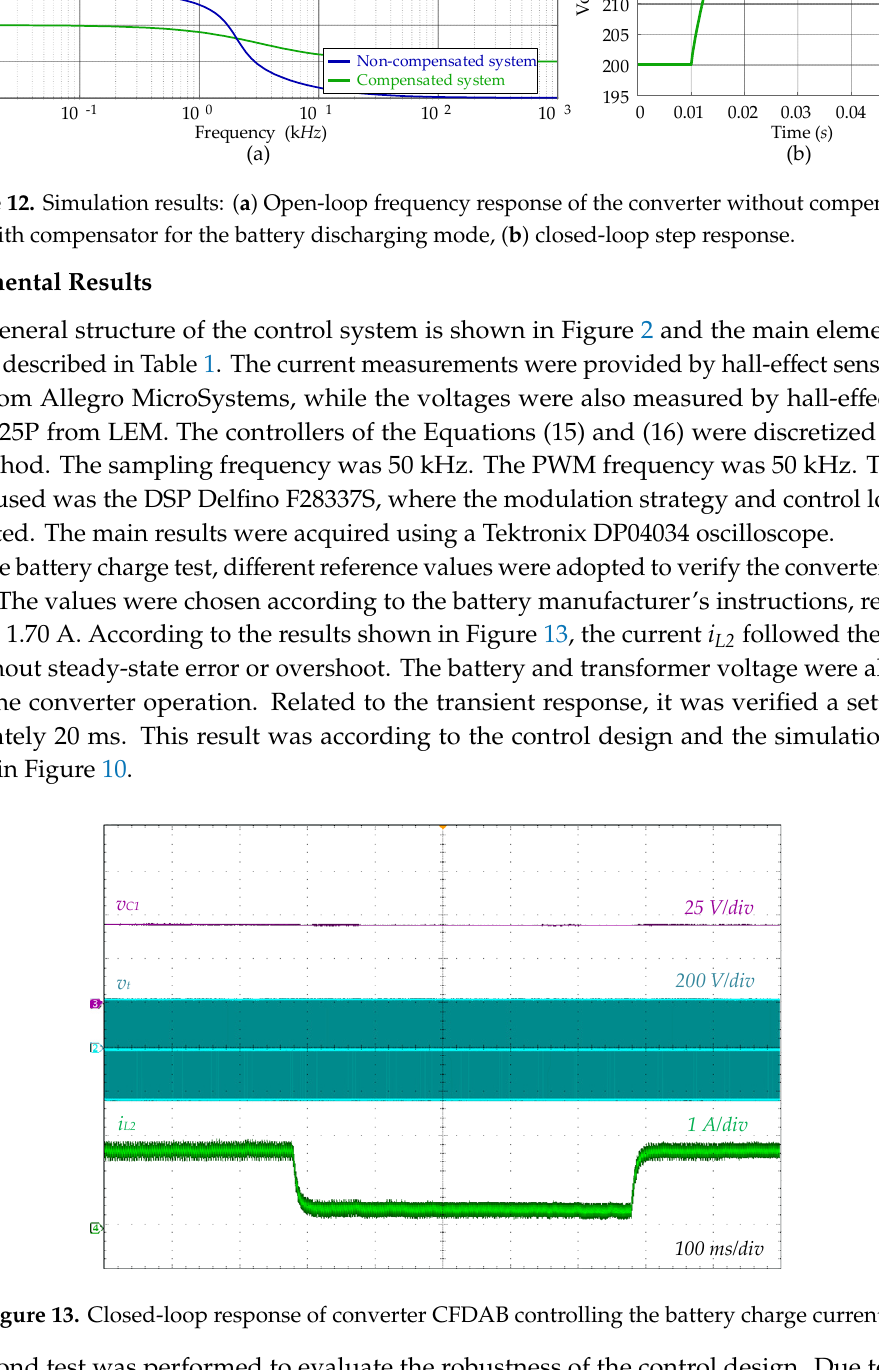
(b) Figure 14. Charge current control during the batteries charge process: ( a ) Low state of charge and regulation of the charge current, ( b ) high state of charge and regulation of the charge current. A second test was performed to evaluate the robustness of the control design. Due to the long time charging, different results were obtained during the evolution of the batteries’ state of charge. Initially, the battery bank was charged with a constant current, equal to 1.7 A , starting from the initial condition of 48 V . The result is illustrated in Figure 14a. After some time of charging, the battery voltage was approximately 68 V and the charging current remained at 1.7 A , as presented in Figure